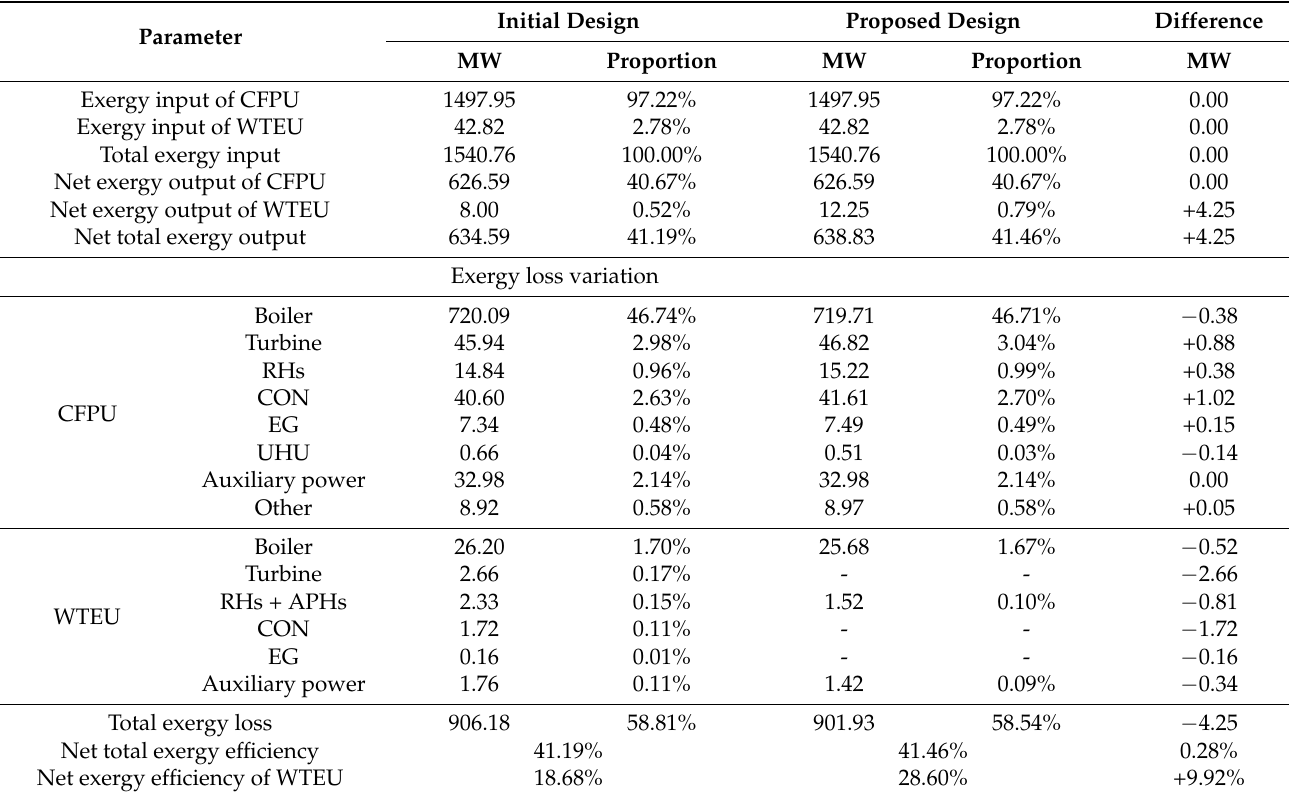
Table 15. Comparison of the exergy analysis results between the initial and proposed designs.